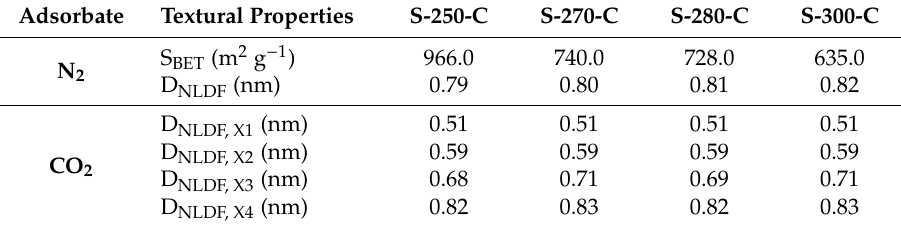
Table 1. Structural properties by N 2 and CO 2 adsorption of PANMFs stabilized at 250, 270, 280,